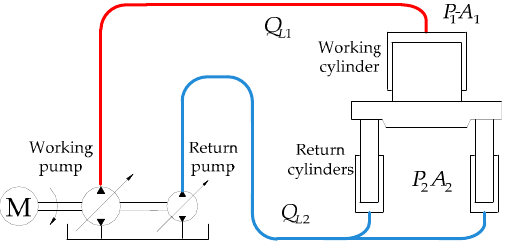
Figure 1. The Open Circuit Pump-controlled Forging Hydraulic System (OCPFHS) diagram.